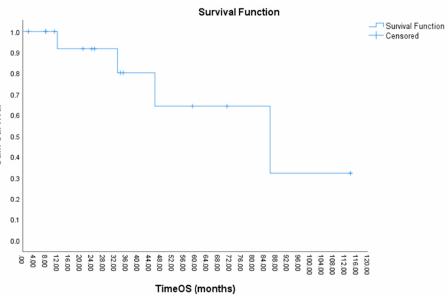
Figure 1. Estimated median overall survival (OS) of patients with SCLC receiving salvage surgery, using the Kaplan–Meier method. using the Kaplan–Meier